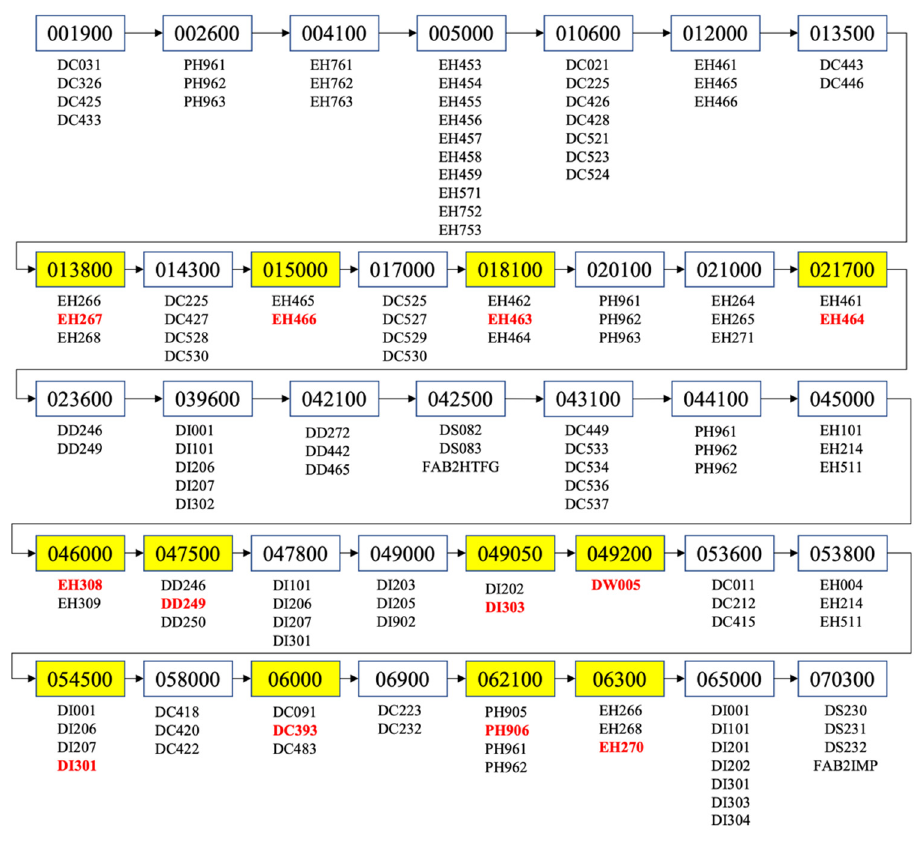
Figure 5. The results of the association rules are arranged in order of the stations.